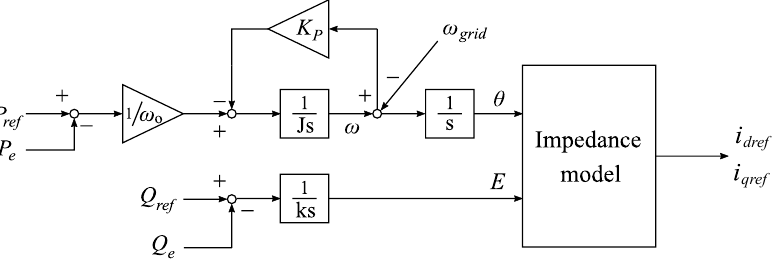
Figure 6. Block diagram of VSG control strategy.